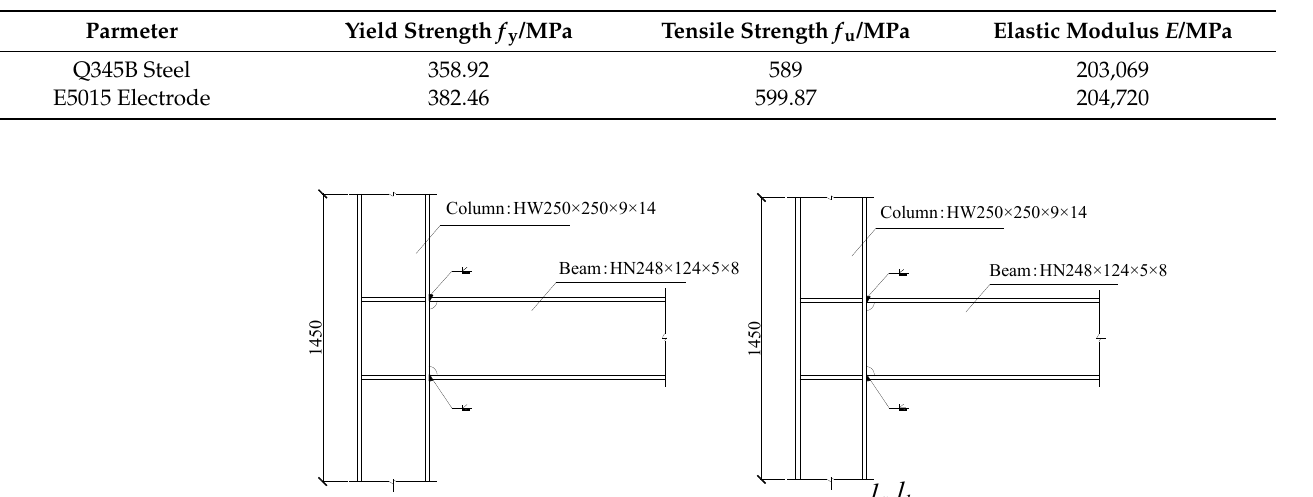
Table 1. Q345B steel and E5015 electrode material test results.